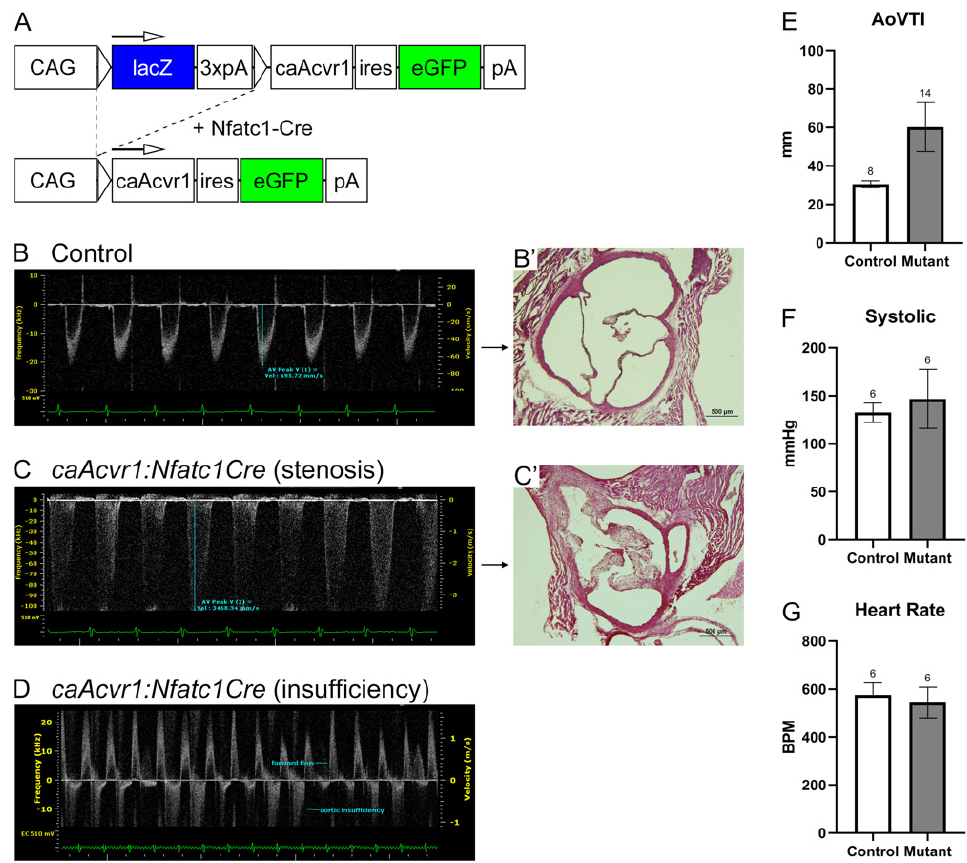
Figure 2. caAcvr1:Nfatc1Cre mutants suffered from functional aortic valve defects. ( A ) Schematic presentation of the Cre-activatable caAcvr1 transgene design. ( B , C ) Echocardiography of a control ( B ) and caAcvr1:Nfatc1Cre mutants (four months old) with aortic valve insufficiency ( C ) and aortic stenosis ( D ) (( B ’, C ’) show the aortic valve histology of the corresponding samples shown in ( B , C )). A bar graph ( E ) depicts a difference in the aortic velocity time integral (AoVTI, mm) between the controls and mutants. No differences in blood pressure (( F ), mmHg) or heart rate (( G ), BPM) were detected between the controls and mutants (white columns, controls; gray columns, mutants; error bars, SEM; * p < 0.05; n = 8 controls and 16